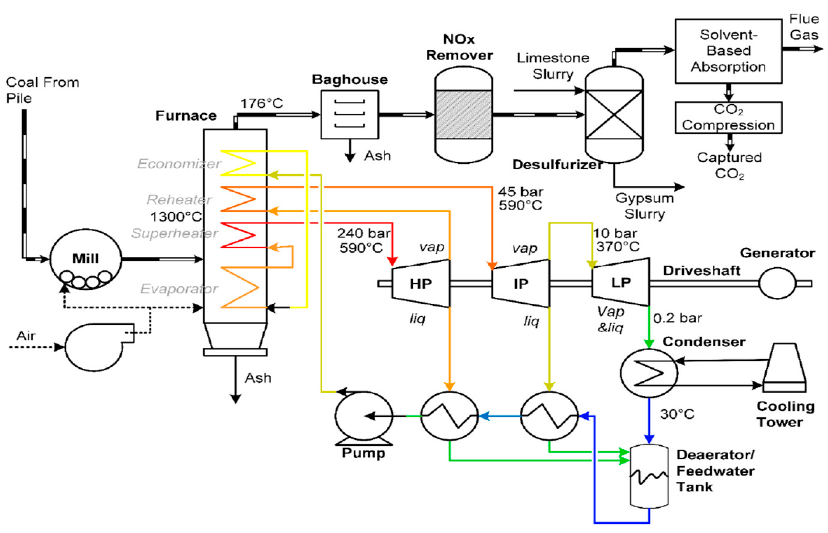
Figure 4. Layout of a post combustion carbon capture coal-fired power plant [33].